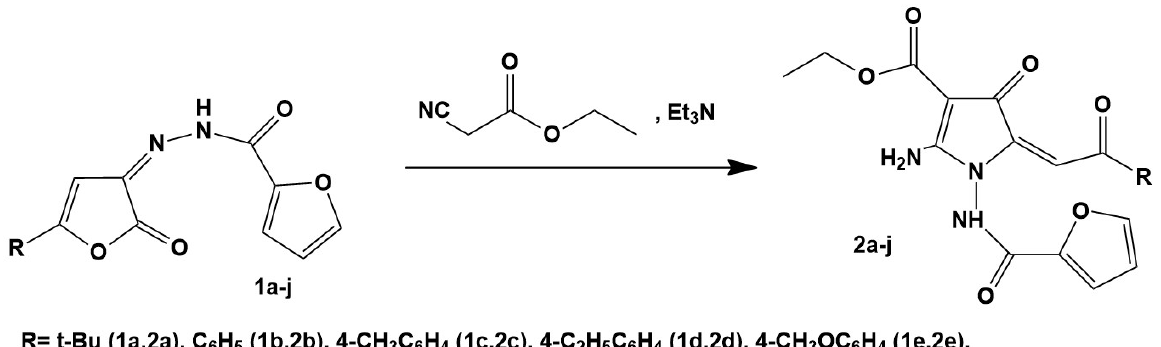
Figure 1. The common synthetic pathway of the derivatives of 2-amino